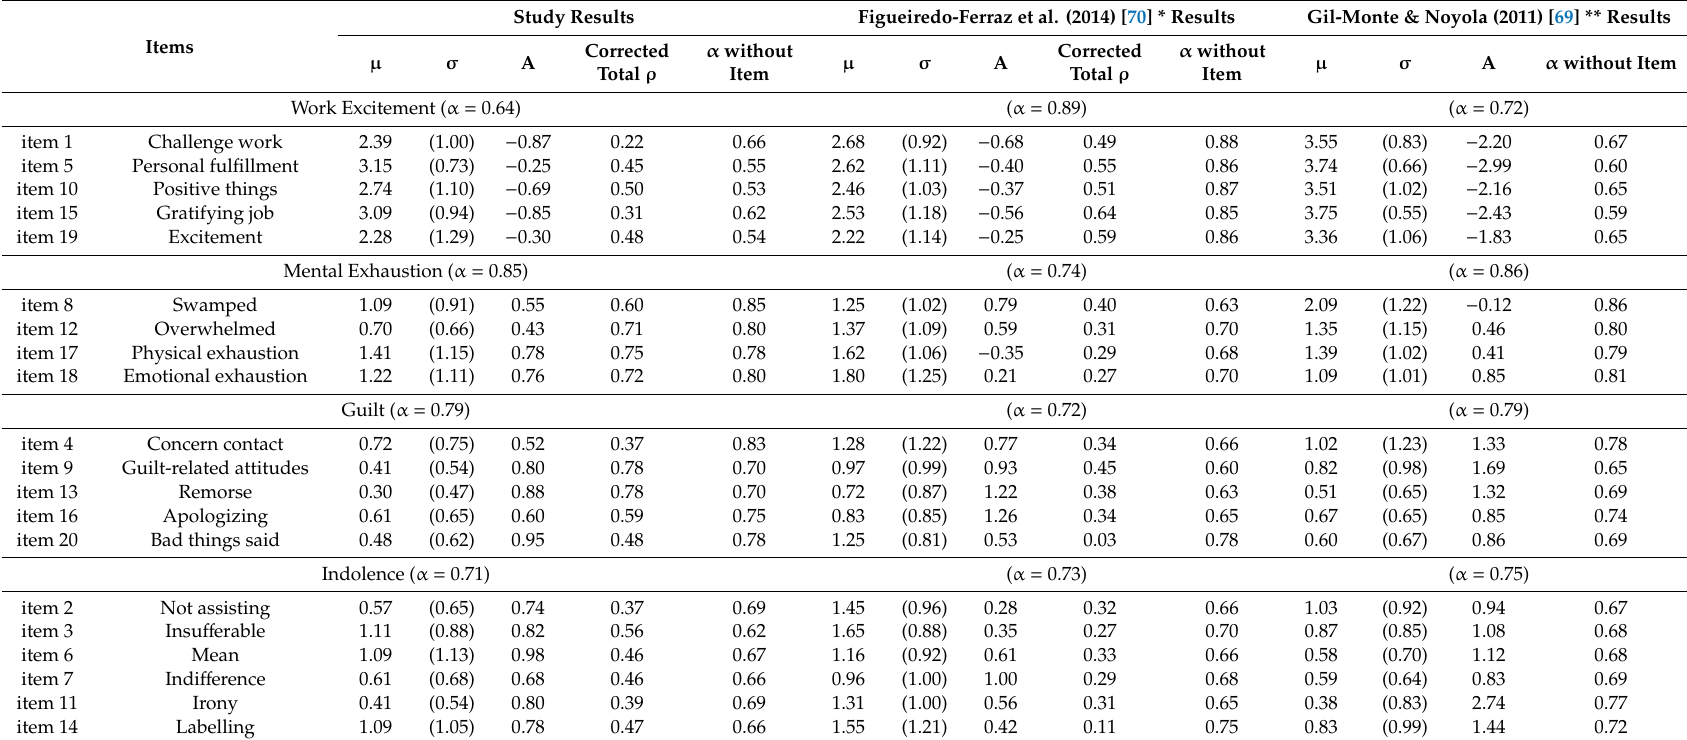
Table 1. Descriptive statistics for the SBI (Spanish Burnout Inventory)